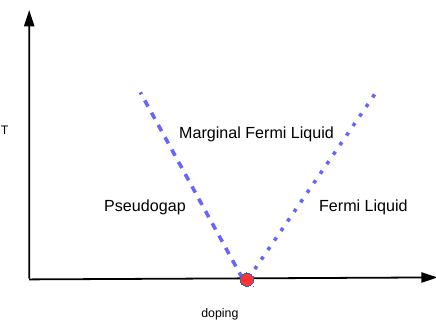
Figure 2. Schematic diagram of the putative phases of the paramagnetic solution of the three- dimensional Hubbard model. The vertical axis is temperature and the horizontal axis is doping level. The red dot represents the quantum critical point. The dashed line represents a crossover between the pseudogap and the marginal Fermi liquid. The dotted line represents a crossover between the Fermi liquid and the marginal Fermi liquid. We have not determined the crossover line between the pseudogap phase and the marginal Fermi liquid in this study. The location of the quantum critical point for the parameters of the Hubbard model that we used ( U = 9 t ) is estimated to be around filling, N = 0.95. The crossover line between the Fermi liquid and the marginal Fermi liquid is determined by the quasi-particle weight. See details in Section 2.6. The precise shape of the crossover lines is dictated by the dynamical exponent of the quantum critical point, we have not attempted to estimate its value in the present